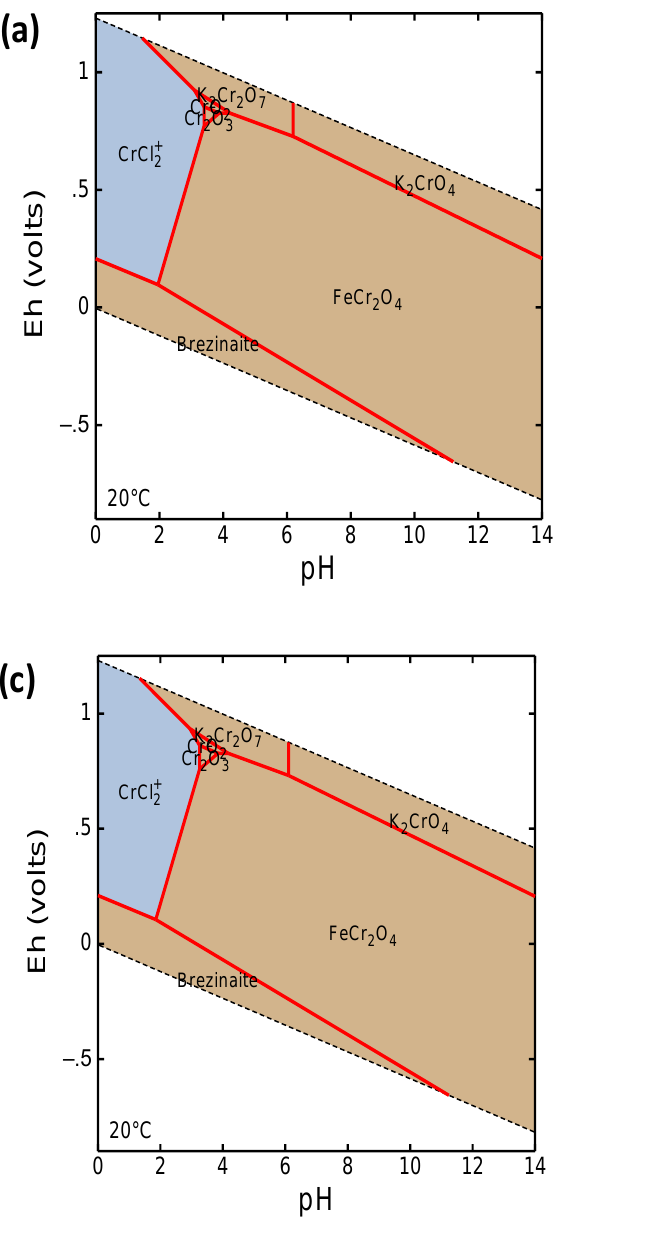
Figure 4. E h -pH diagram for Cr-contaminated tannery wastewater collected in summer ( a ) Cr with other wastewater parameters and ( b ) Fe with other wastewater parameters); and winter ( c ) Cr with other wastewater parameters and ( d ) Fe with other wastewater parameters).